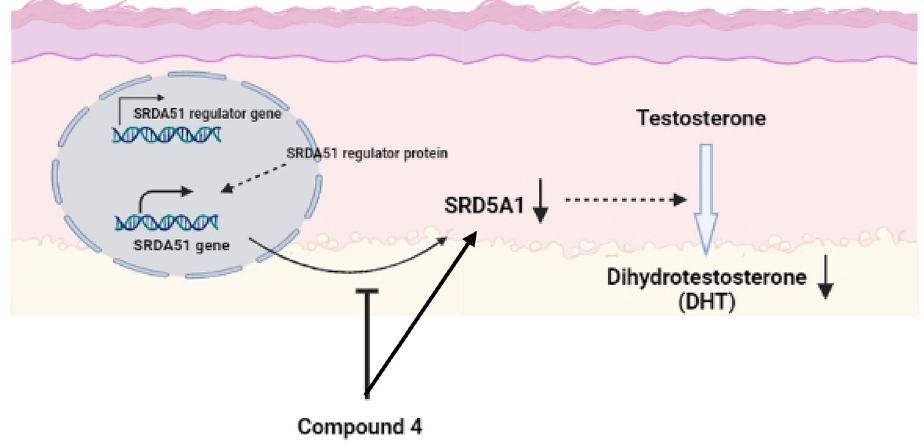
Figure 8. Schematic diagram demonstrating a possible mechanism of compound 4 on the modulation of SRD5A1 in human keratinocyte cells. Compound 4 mediates the lower level of DHT production together with down-regulating of SRD5A1 protein expression, which possibly involves the mixed-mode